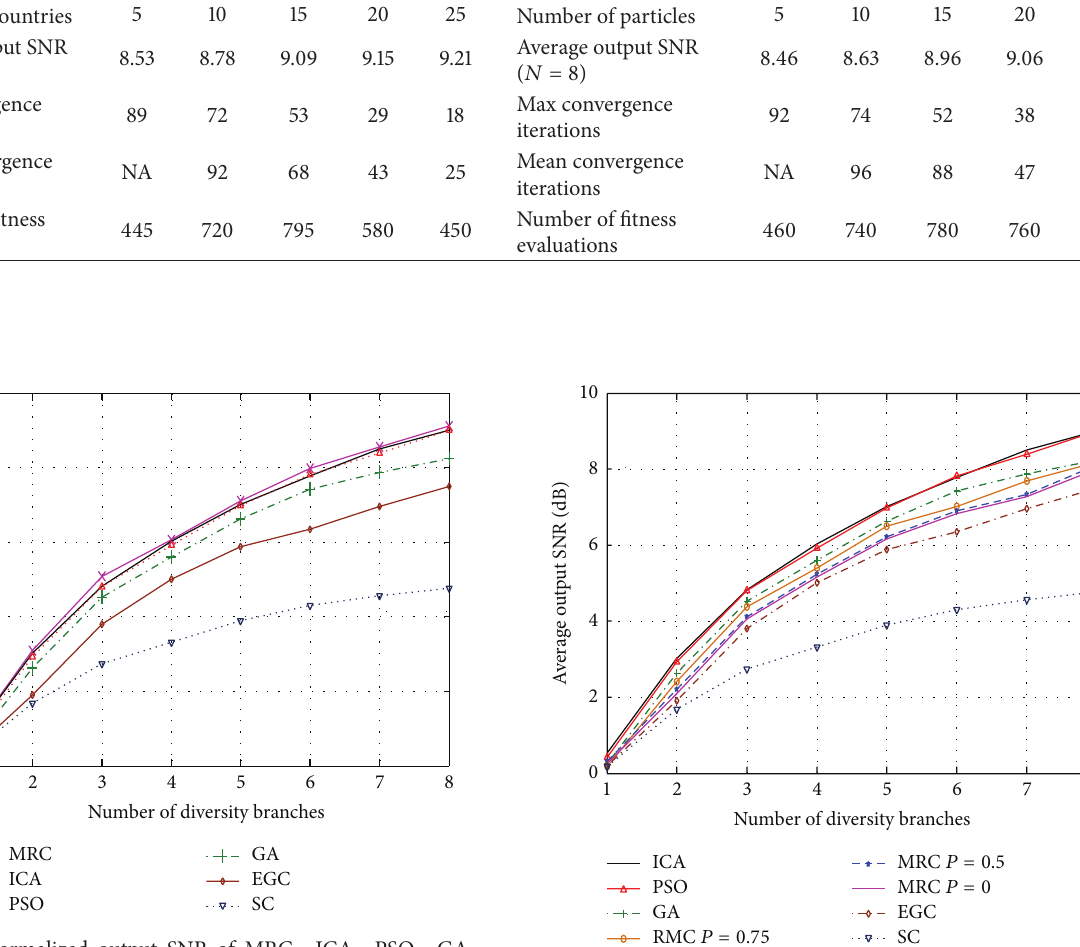
Figure 4: Normalized output SNR of MRC-, ICA-, PSO-, GA-, EGC-, and SC-based methods when the channel is perfectly esti- mated.